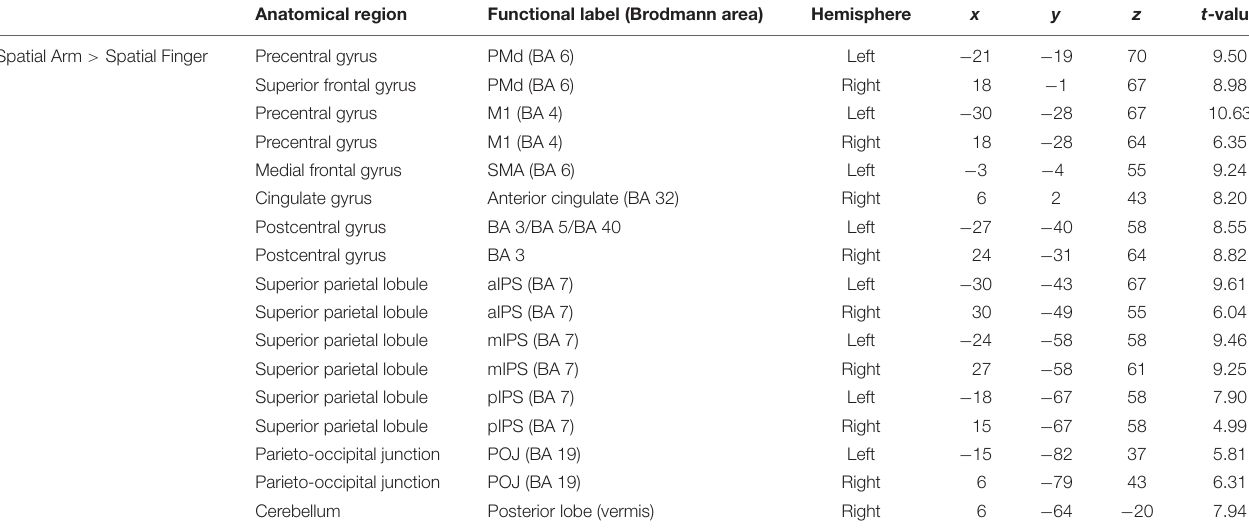
Cerebellum Posterior lobe